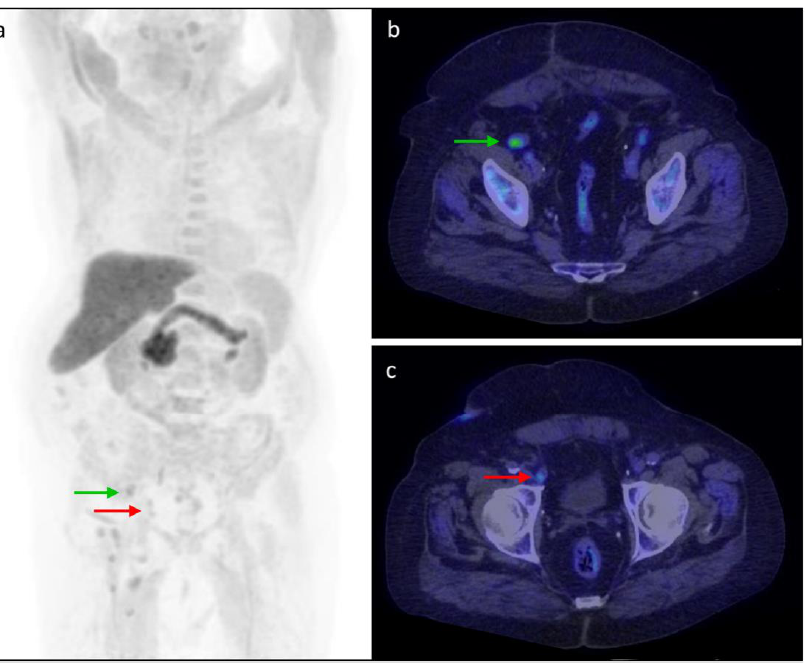
Figure 5. An 81-year-old patient with BCR after prostatectomy and Gleason Score 6 (3 + 3) underwent the [ 18 F]fluciclovine PET/CT. PSA increased to 2.15 ng/mL with PSAdt of 13.6 months. The ( a ) MIP and ( b , c ) axial fused images showed recurrent lymph node lesions, namely ( b ) a right external iliac lymph node with SUVmax 5.6 (green arrow) and ( c ) a right deep inguinal lymph node with SUVmax 5.2 (red arrow).